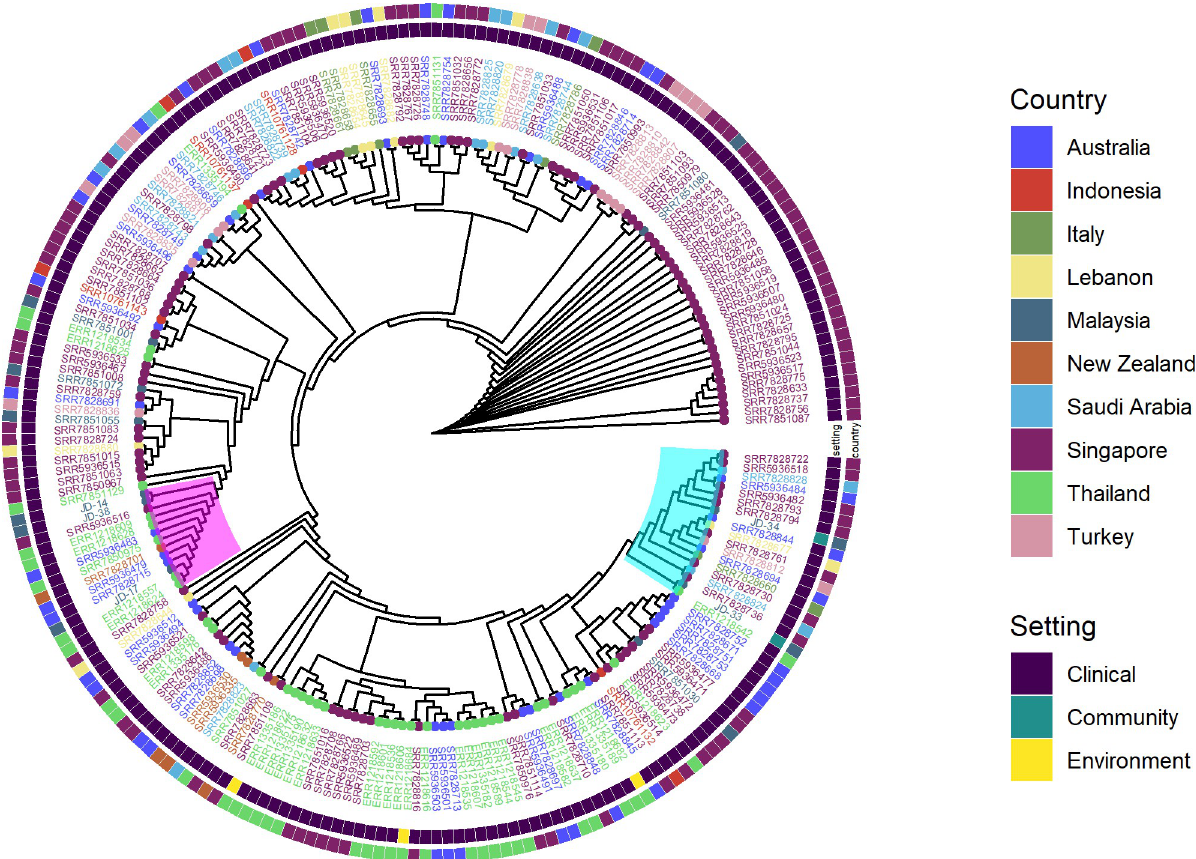
Fig 3. SNP-based pan-genome comparison of ESBL-producing Escherichia coli ST 131 from Segamat (n = 5) with public ST131 sequences (n = 220). The clade containing the community ST131 isolates from Segamat was highlighted in turquoise, while the Segamat clinical ST131 isolates were mapped in the clade highlighted in